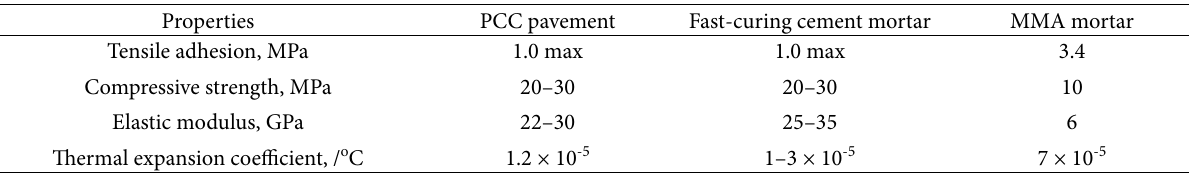
Table 2. Mechanical testing results of MMA mortar